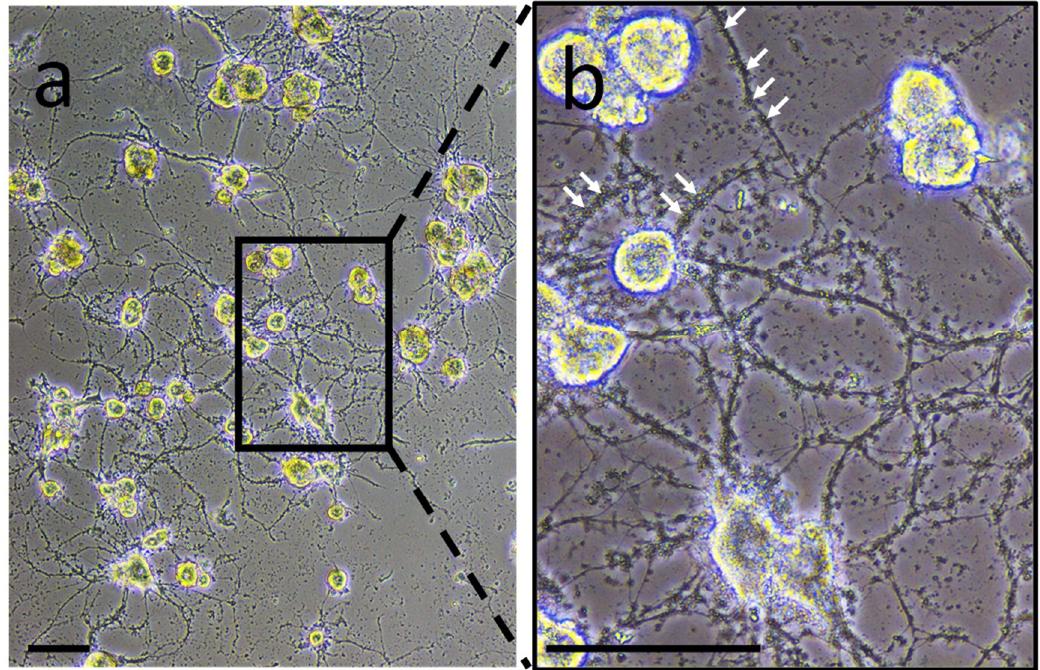
Figure 1. Neurons and microglia primary co-culture. ( a ) During the co-culture, adherent neurons exhibit neurite outgrowth while activated microglial cells are still floating. The renewal of the culture medium washed away the microglial cells while maintaining the neurons and some products released from both cell populations. ( b ) Enlargement showing vesicle-like structures (white arrows as examples) interacting with neurites. Scale bars correspond to 50 µm.